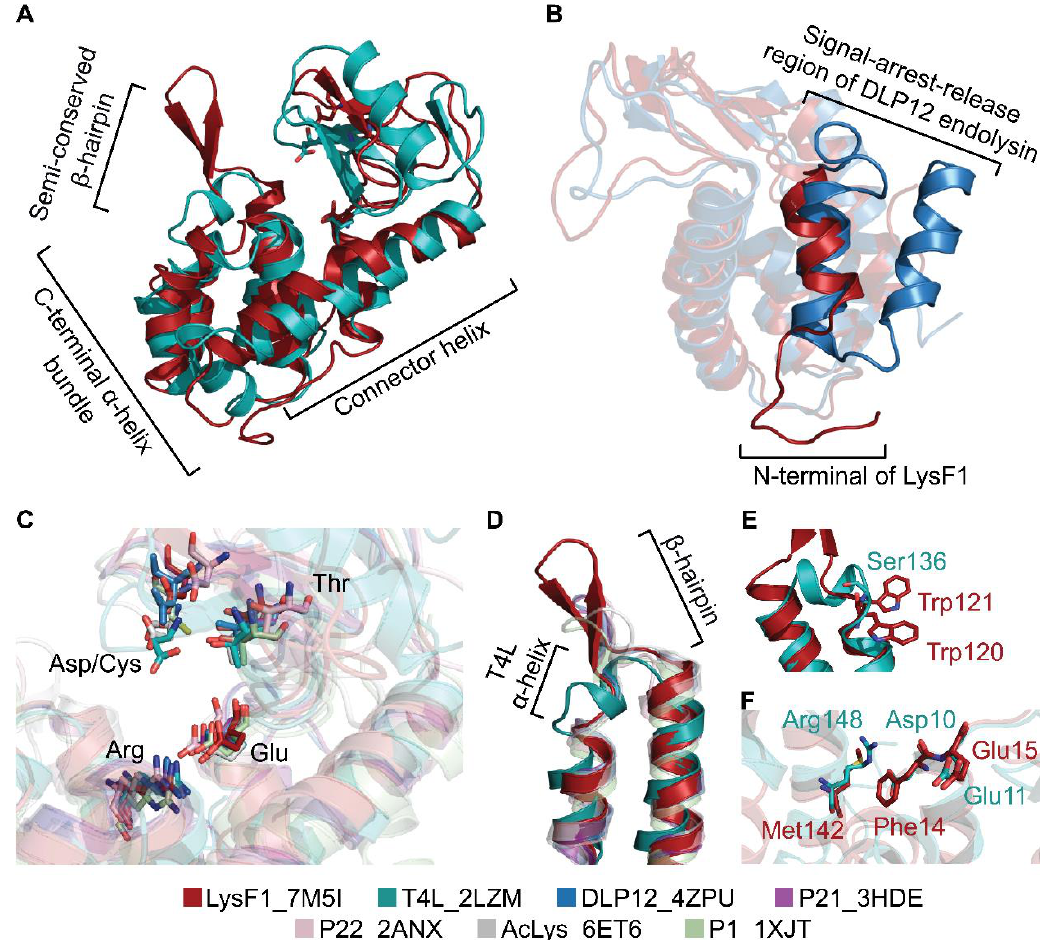
Figure 6. Comparison of LysF1 with related T4L-like endolysin structures. ( A ) An overlay of the cartoon model of LysF1 (red) with T4L (teal), as a representative of the T4L-like endolysin family, illustrates the conservation of the protein fold. ( B ) Overlay of the N-terminals of LysF1 with signal–arrest–release endolysin DLP12 (blue) shows that LysF1 does not contain the α-helix characteristic of signal–arrest–release endolysins. ( C ) A comparison of the active site residues highlights the conservation of Glu, Thr and Asp/Cys in terms of sequence and spatial orientation. High conservation of Arg, which is proposed to position the Glu through the formation of a salt bridge, indicates its importance. ( D ) The C-terminal bundle of this protein fold contains two α-helices that are connected via a β-hairpin of varying sizes in all compared structures except T4L which contains an α-helix. ( E ) The equivalent residue of Ser136 in T4L is a bulky tryptophan. ( F ) The salt bridge forming Asp10 in T4L is replaced with a hydrophobic phenylalanine residue in LysF1.